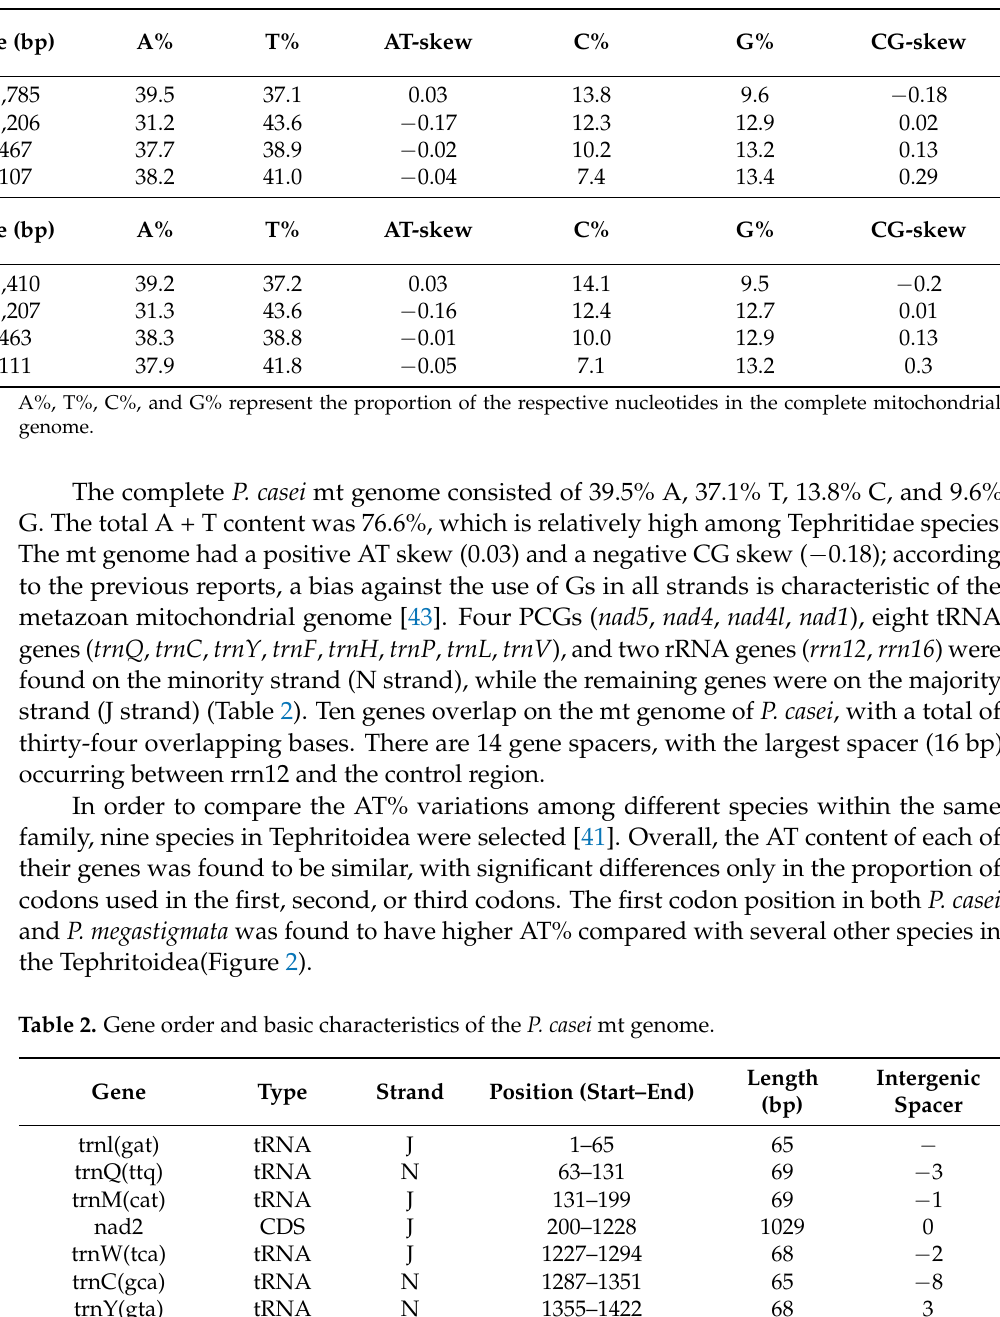
Table 1. The base composition of the complete mt genome of P. casei and P. megastigmata .